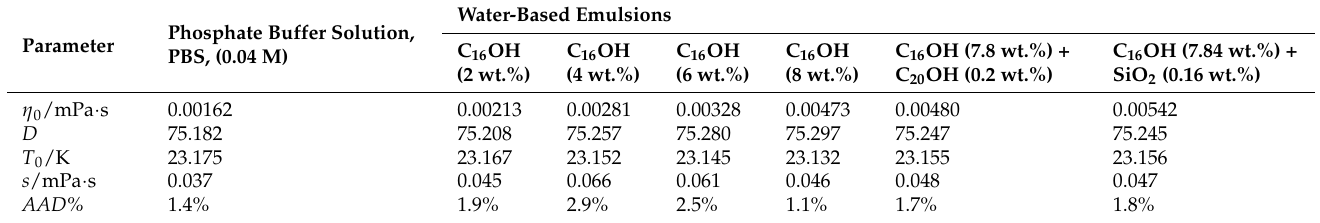
Table 3. Fitting parameters ( η 0 , D and T 0 ); standard deviations ( s ) and absolute average deviations ( AAD% ) obtained from the Vogel-Fulcher-Tamman-Hesse model, Equation (3), when modeling the temperature dependence of the shear viscosities obtained for some representative samples at ~100 s − 1 .